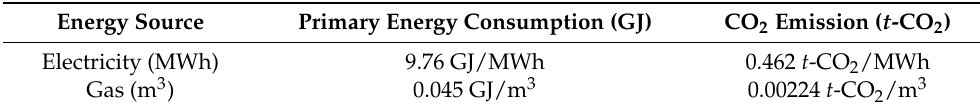
Table 2. Conversion factors for energy consumption and CO 2 emission.